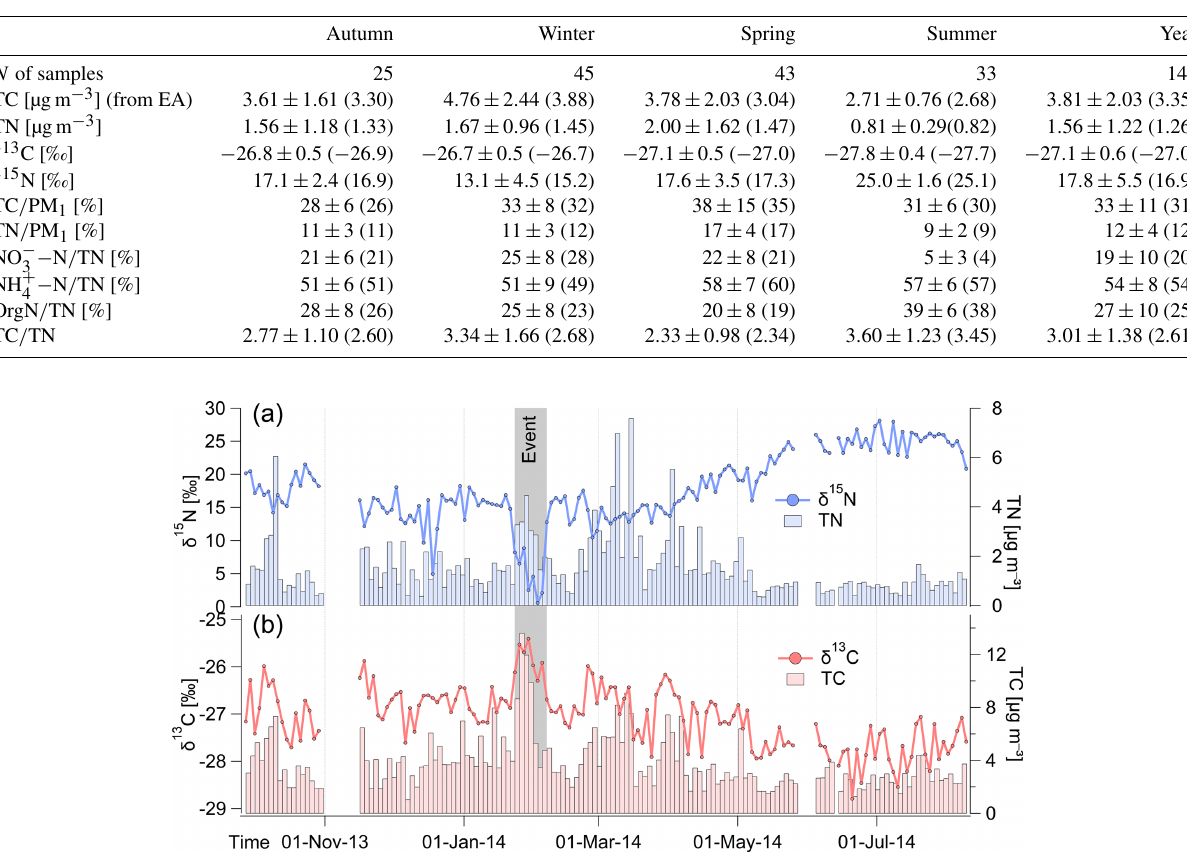
Figure 1. Time series of δ 15 N with TN (a) , and δ 13 C and TC (b) in PM 1 aerosols at the Košetice station. The gray color highlights an event with divergent values, especially for δ 15